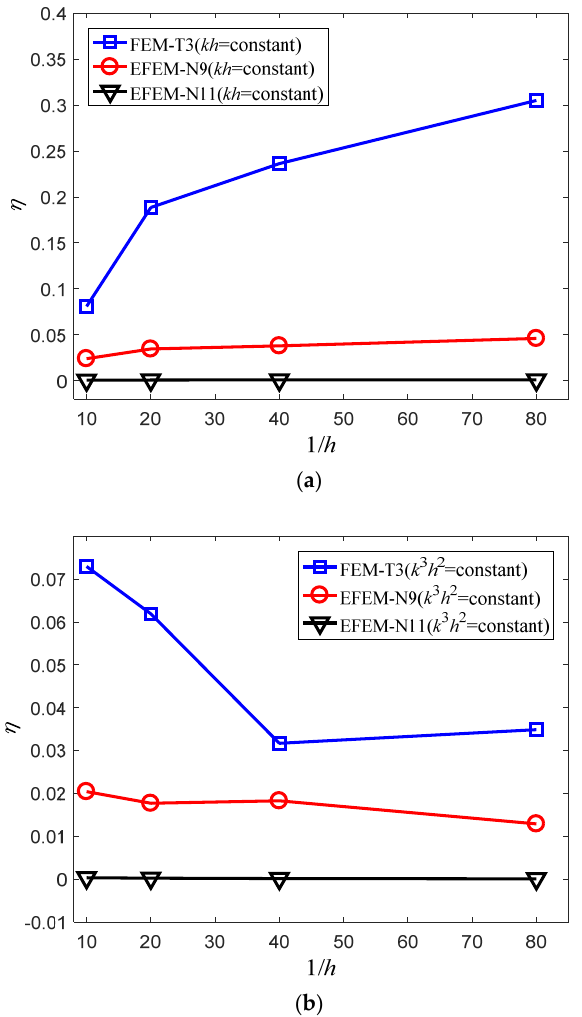
Figure 9. Comparison of the numerical performance of different methods in controlling the different numerical error components: ( a ) keeping kh = constant; ( b ) keeping k 3 h 2 = constant.